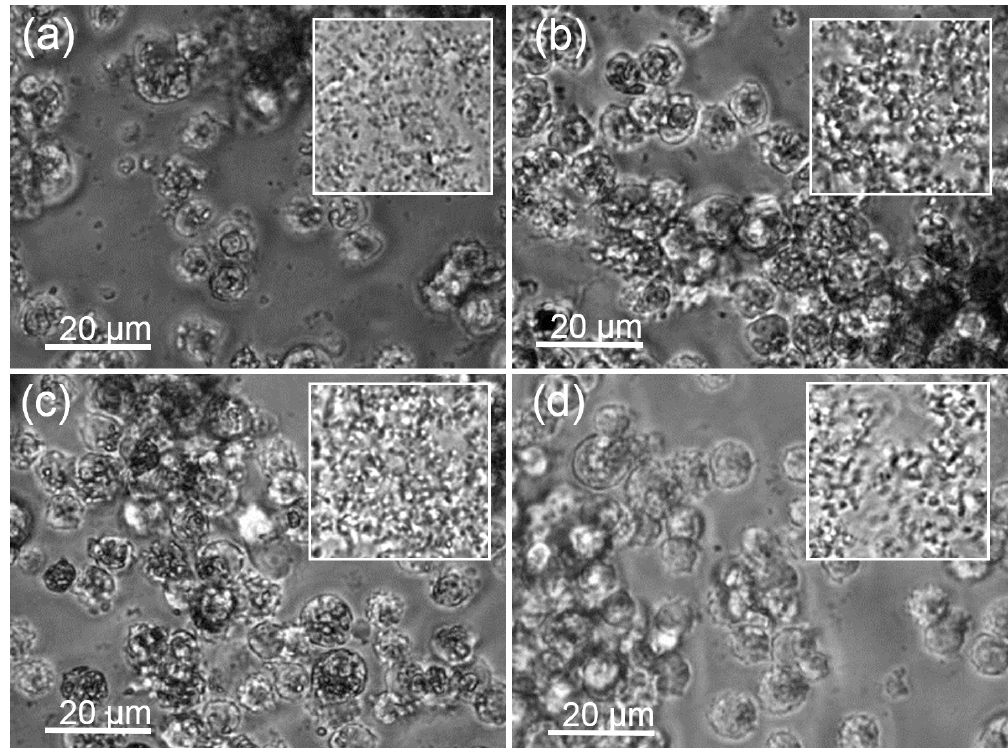
Figure 3. Uptake of ZrO 2 particle agglomerates by alveolar macrophages under testing conditions. ( a ) ZrO 2 -Acryl, ( b ) ZrO 2 -TODS, ( c ) ZrO 2 -APTS, and ( d ) ZrO 2 -PGA. Cultures of 3 × 10 5 cells per well of a 96-well plate were laden with differently coated ZrO 2 NPs (90 µ g/mL), as indicated and incubated for 16 h. Insets show particles settled under identical conditions in the absence of cells. Note that the space between cells is largely cleared from particles and that cells contain dark material.